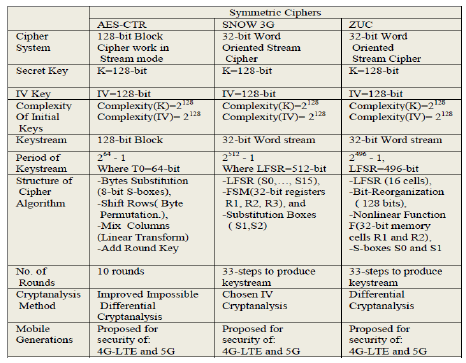
Table 2. Symmetric Ciphers AES-CTR, SNOW 3G, and